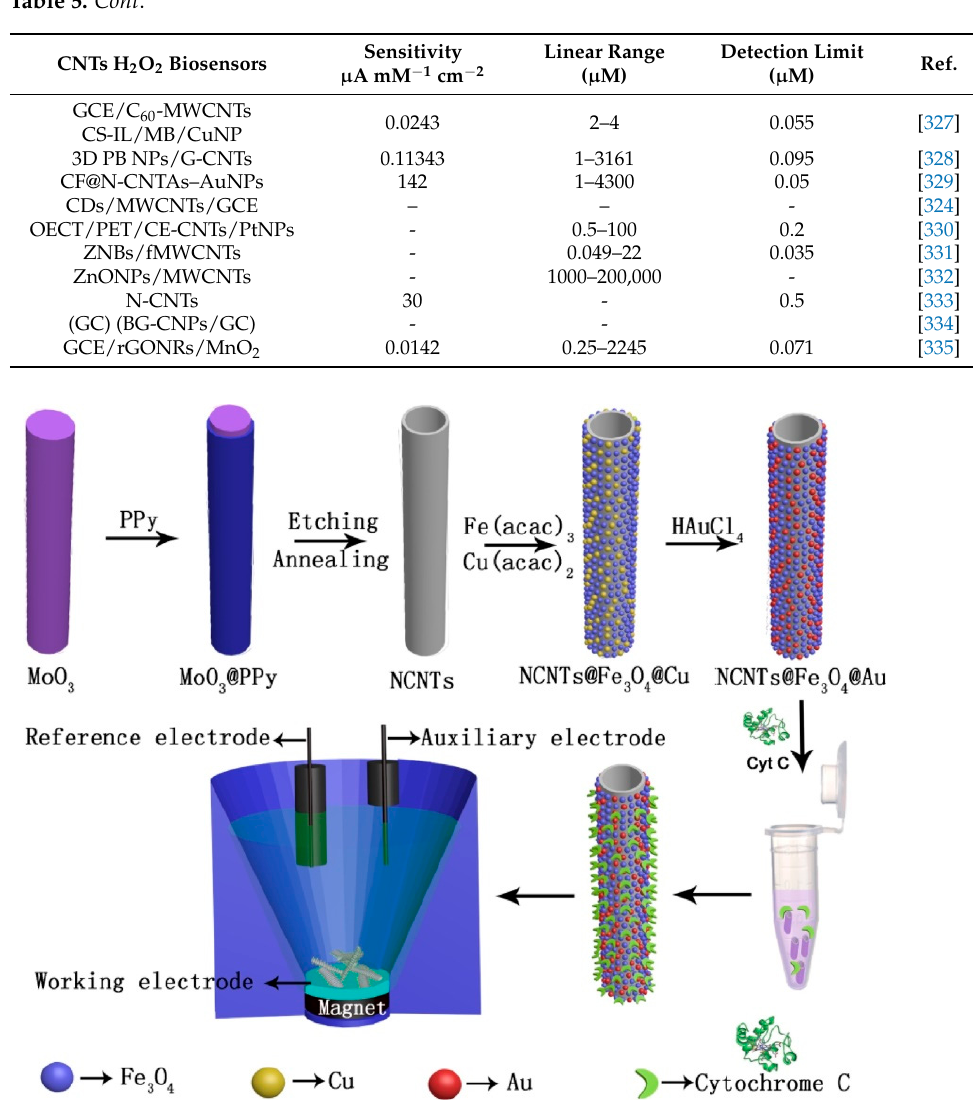
Figure 6. Enzyme-loaded CNTs for the detection of H 2 O 2 in living cells. Reproduced with permission from [336]. Copyright 2019, Elsevier Ltd (Amsterdam, The Netherlands).